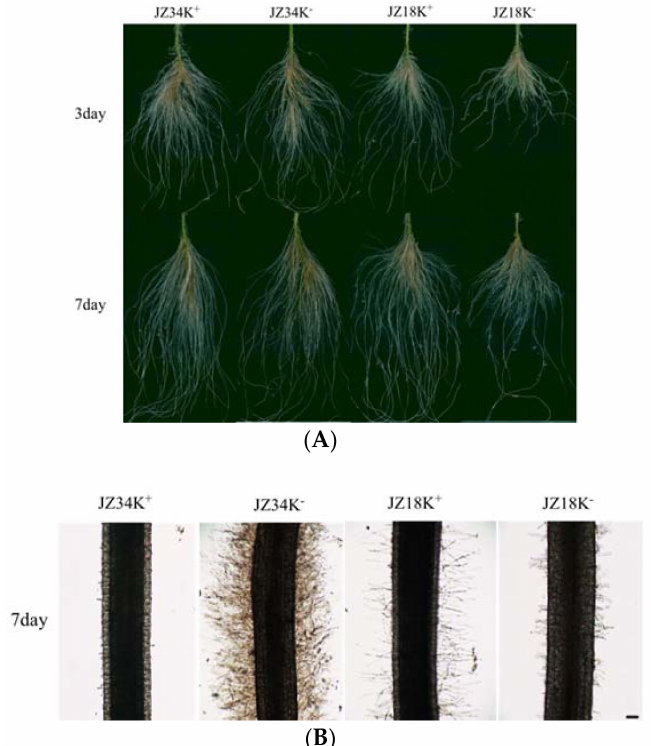
Figure 1. Comparison of morphological changes in the roots of different tomato genotypes under K + -deficiency stress conditions at 3 d and 7 d ( A ); changes in the root hair region in different tomato genotypes under K + -deficiency stress conditions at 7 d. Roots were observed at 100 × magnification; scale bars: 0.01 cm ( B ). K + represents normal K + (4 mM); K − represents K + deficiency (0 mM). The experiments were repeated three